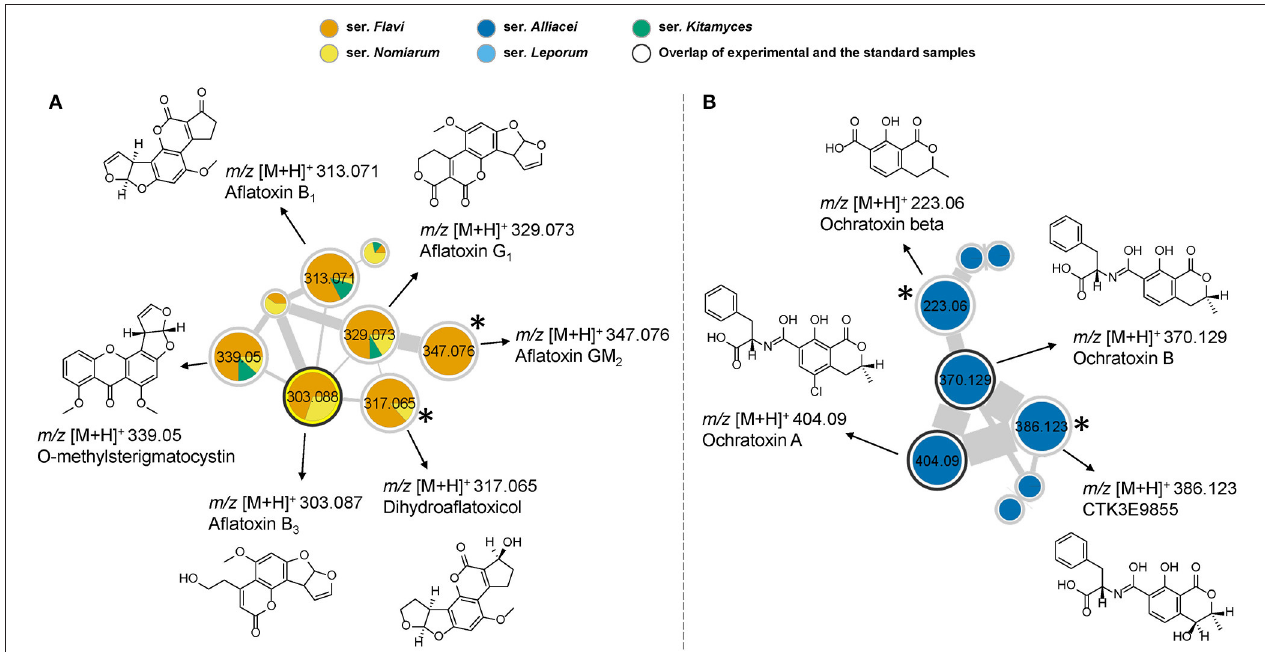
FIGURE 3 | (A) Molecular network cluster of aflatoxins. (B) Cluster of ochratoxins and their analogs. Nodes with bold outlined black circles are the overlap of molecules and the standard compounds, while the nodes marked with asterisk are the molecules found from the structural relationship shown in molecular networks.